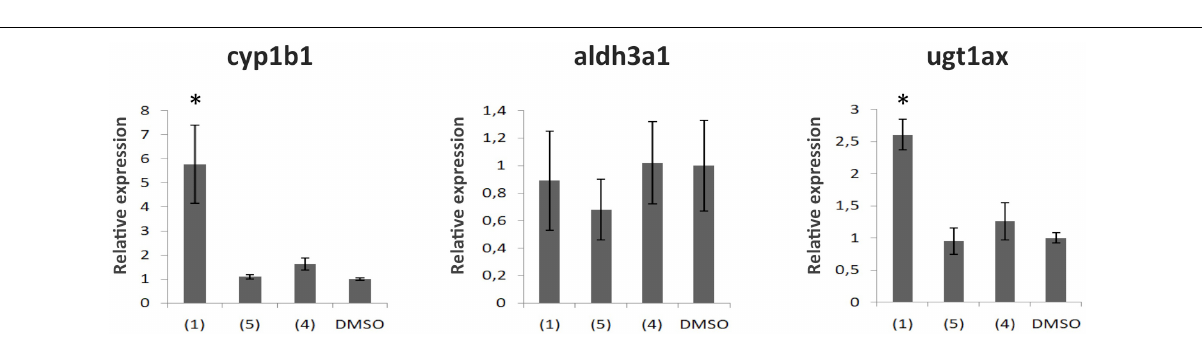
FIGURE 7 | The effect of compounds from the dibenzofuran family on the mRNA expression of Ahr dependent genes. Gene expression analysis from 30 hpf zebrafish embryos treated for 6 h with 50 µ g/mL of 1 , 4 or 5 . Shown are mRNA levels of cyp1b1, aldh3a1, and the ugt1a superfamily, known to be downstream targets of the Ahr. mRNA expression was normalized against Actin, and the gene expression of embryos treated with DMSO (vehicle) was set as 1. Data are mean ± standard error of the mean (SEM), n = 3, ∗ P <